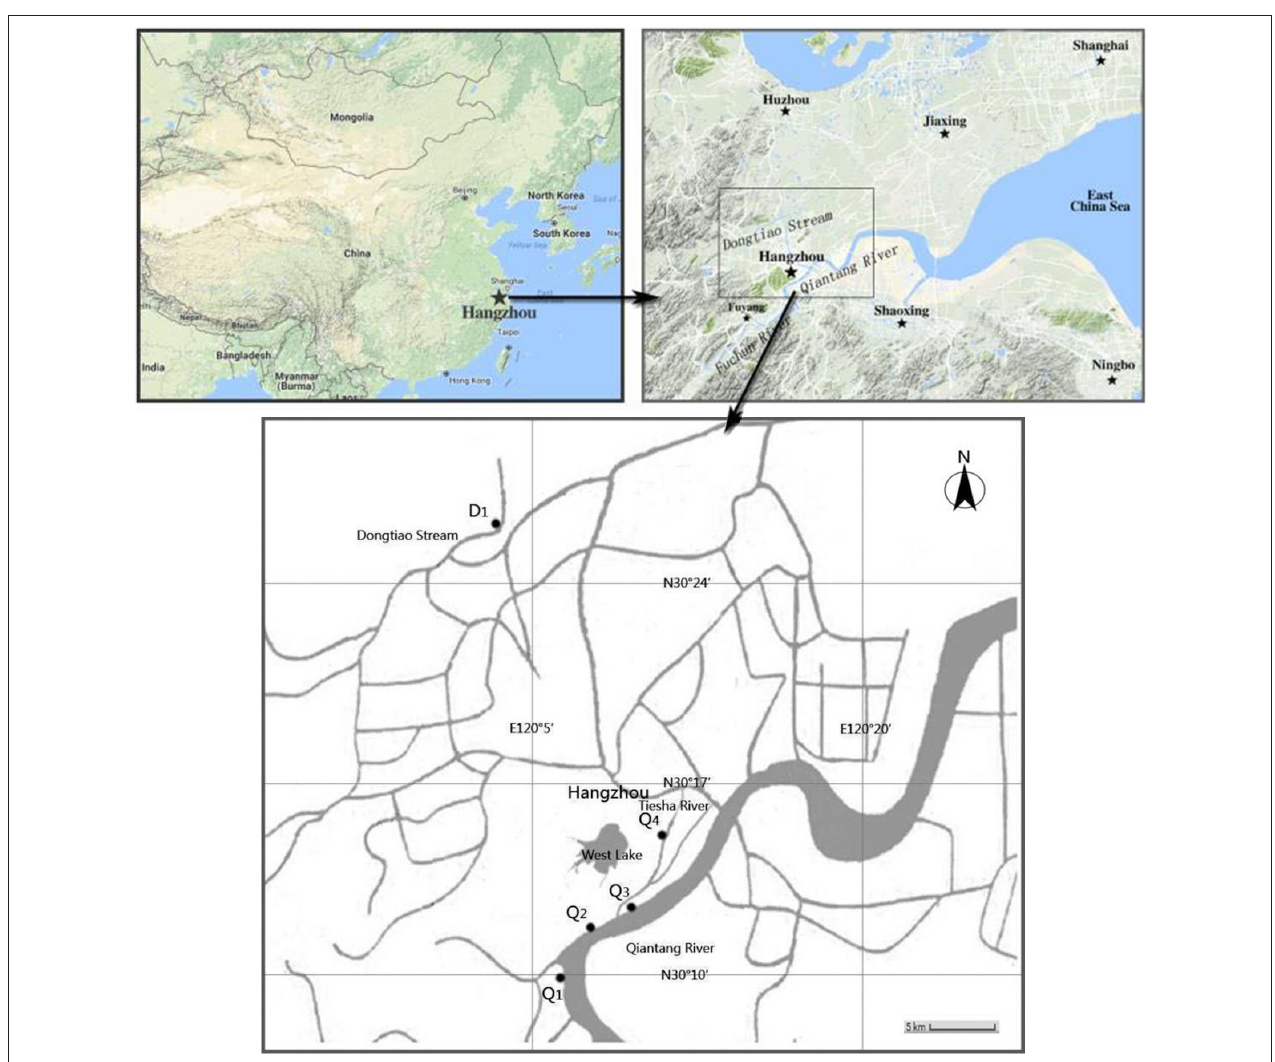
FIGURE 1 | Geographic locations for sampling sites in the Qiantang River and the Dongtiao